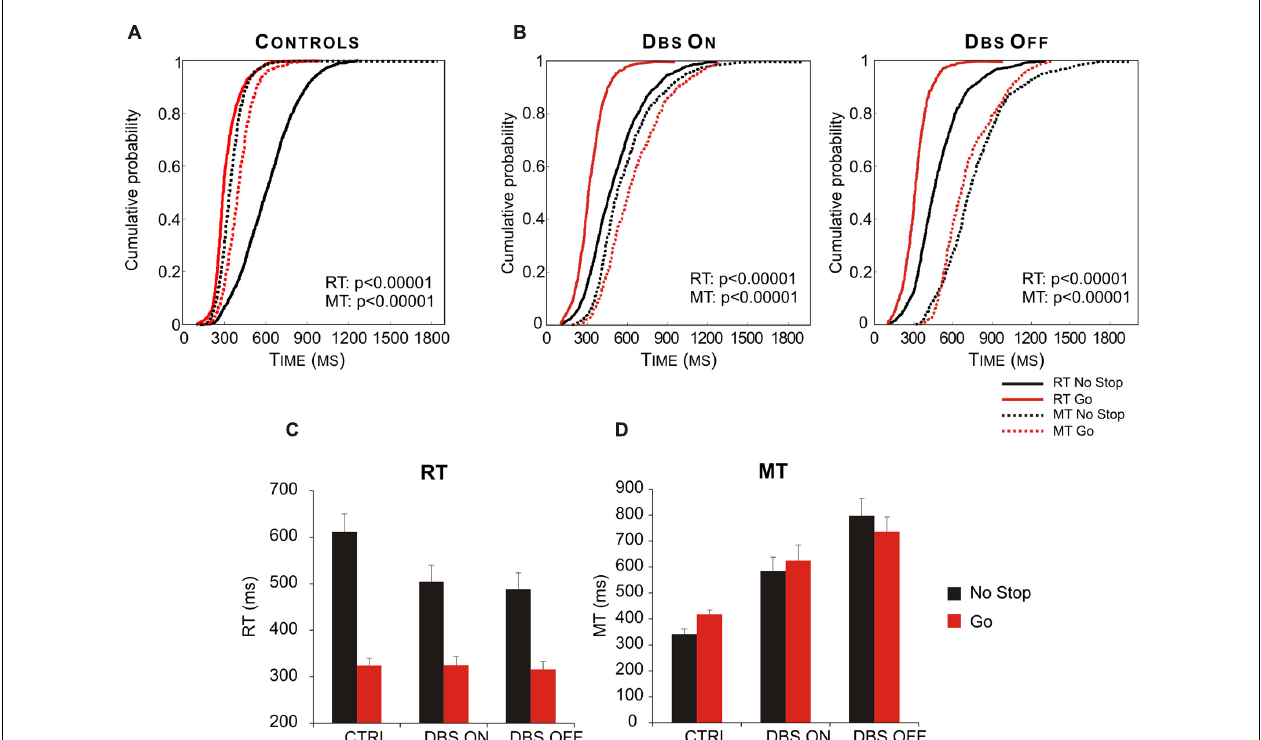
FIGURE 8 | Deep brain stimulation (DBS) of subthalamic nucleus (STN) partially restores the appropriate motor strategy according to the contexts. (A) Cumulative distribution of RTs (solid lines) and MTs (dotted lines) of healthy subjects ( n = 13) for go-only (red lines) and no-stop (black lines) trials. (B) Cumulative distributions of RTs (solid lines) and MTs (dotted lines) of DBS patients ( n = 12) in DBS-ON and DBF-OFF conditions for both go-only (red lines) and no-stop (black lines) trials. For